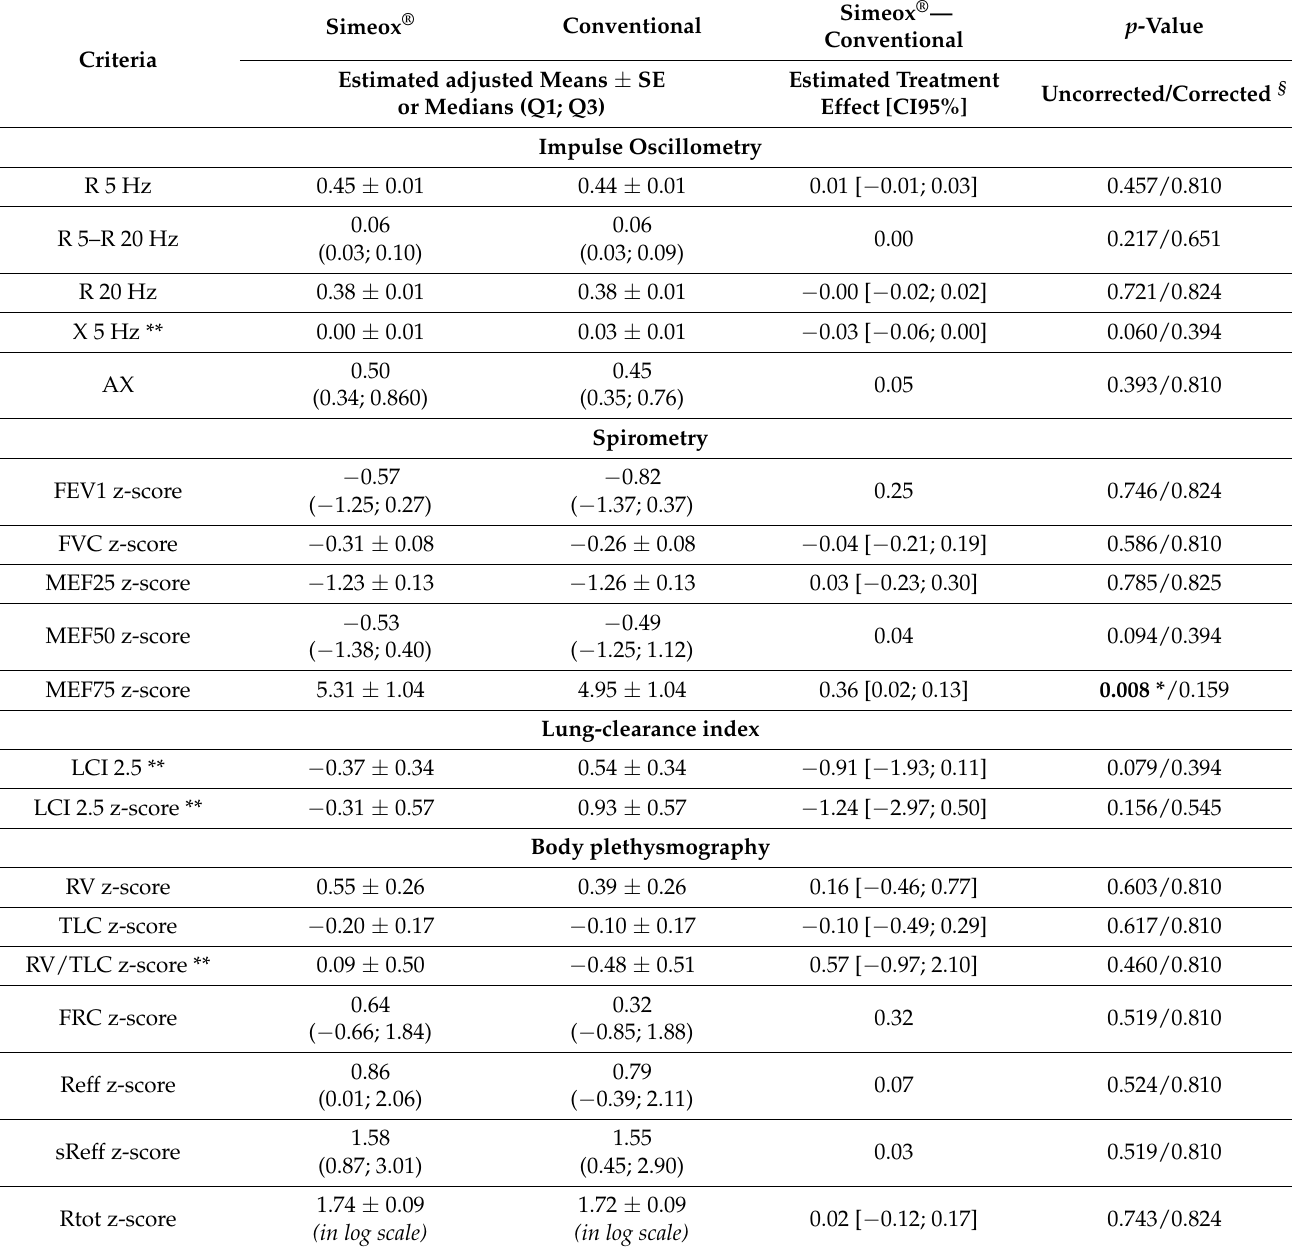
Table 3. Comparisons of treatment effects on pulmonary function tests (estimated mean after one month of